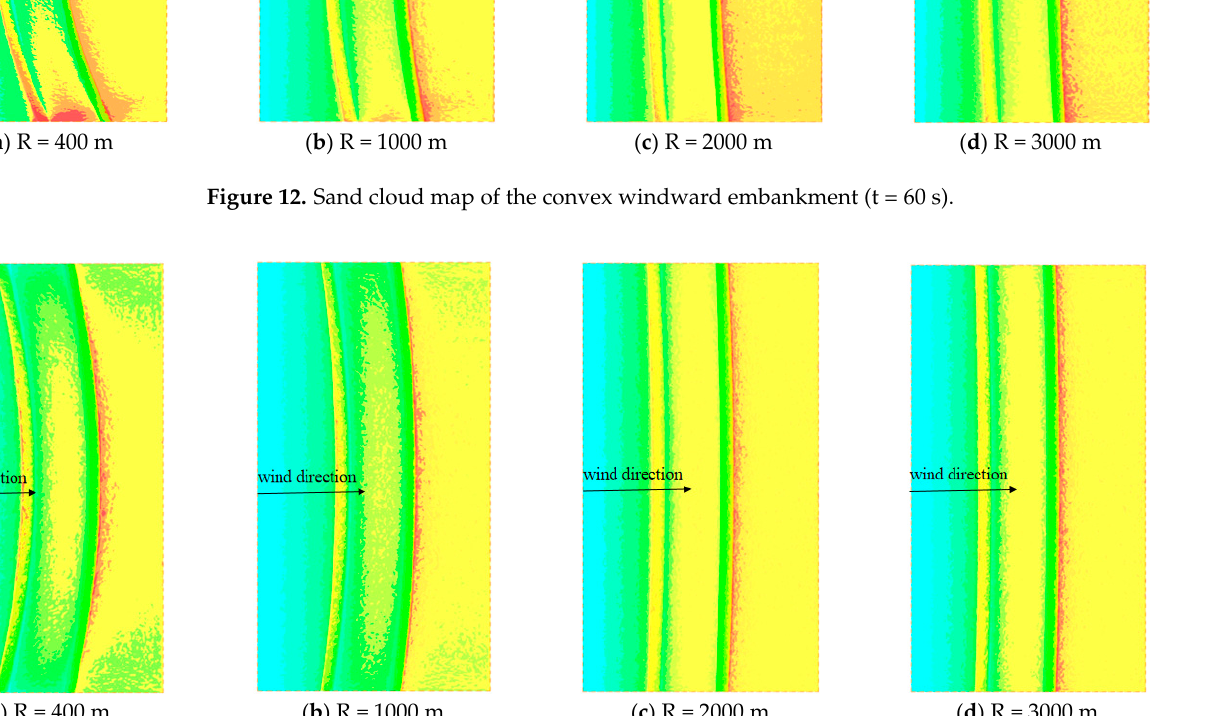
Figure 13. Sand cloud map of the concave windward embankment (t = 60 s).